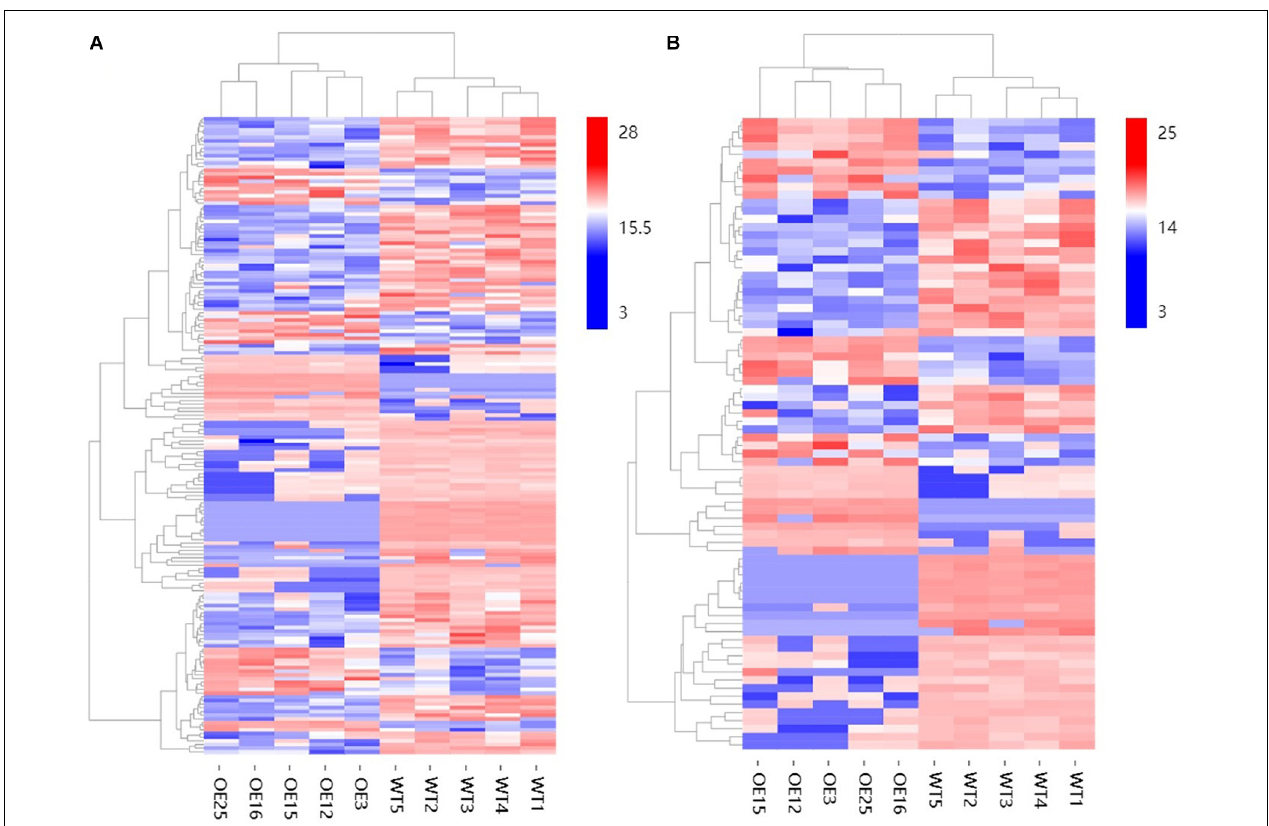
FIGURE 9 | The heatmaps of total differential metabolites (A) and the differential metabolites belong to flavonoids (B) between WT plants and OE-MsASMT1 transgenic plants. TABLE 3 | The forage quality of WT and OE-MsASMT1 transgenic alfalfa.